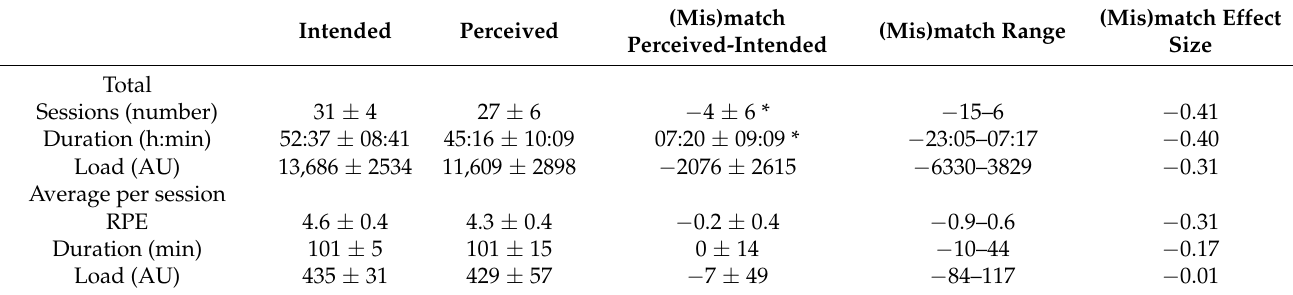
Table 1. Mean values of intended and perceived training variables (n = 14) along with the difference between training variables (perceived minus intended) over four weeks, mean ± SD shown. Total refers to summation over the entire 4-week